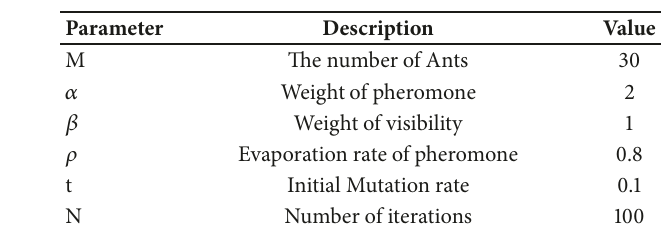
Table 2: HACO parameters